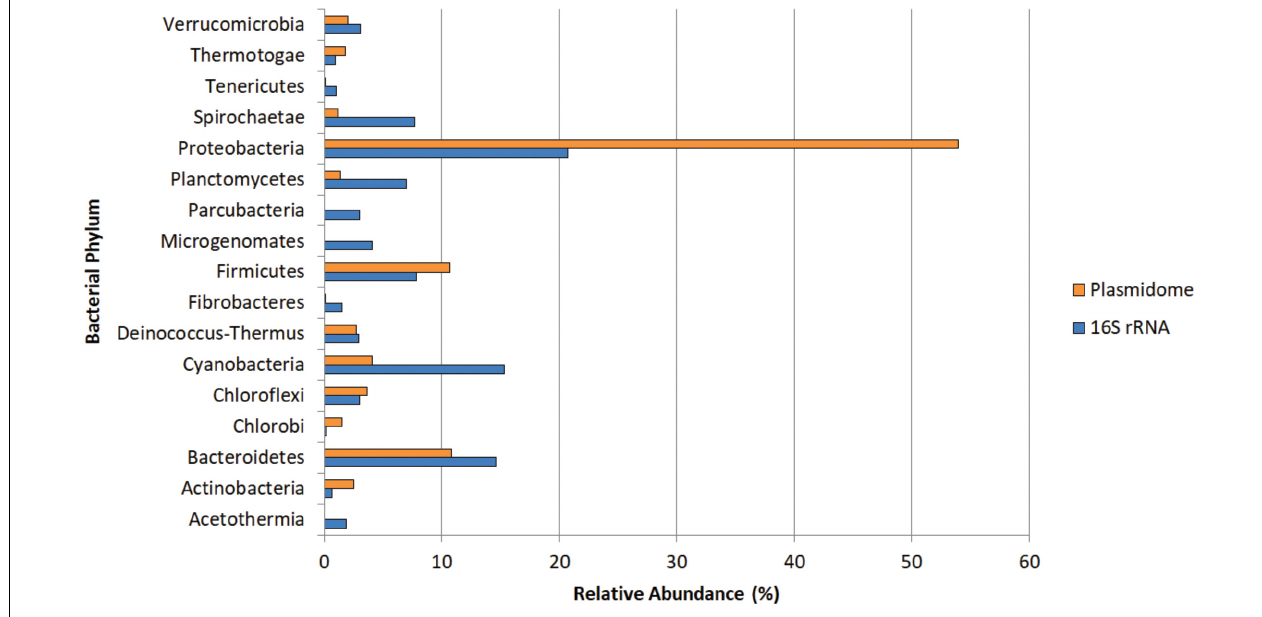
Frontiers in Microbiology |